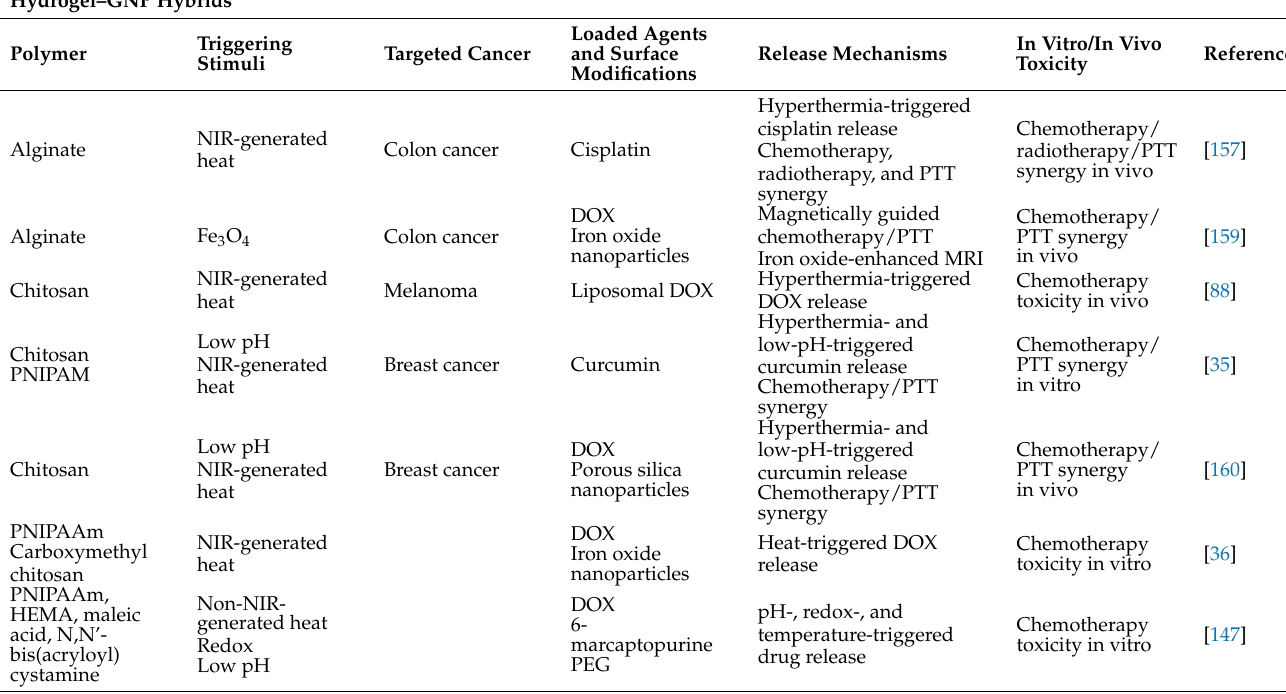
Table 2. Multimodal GNP–polymer nanohybrids for cancer